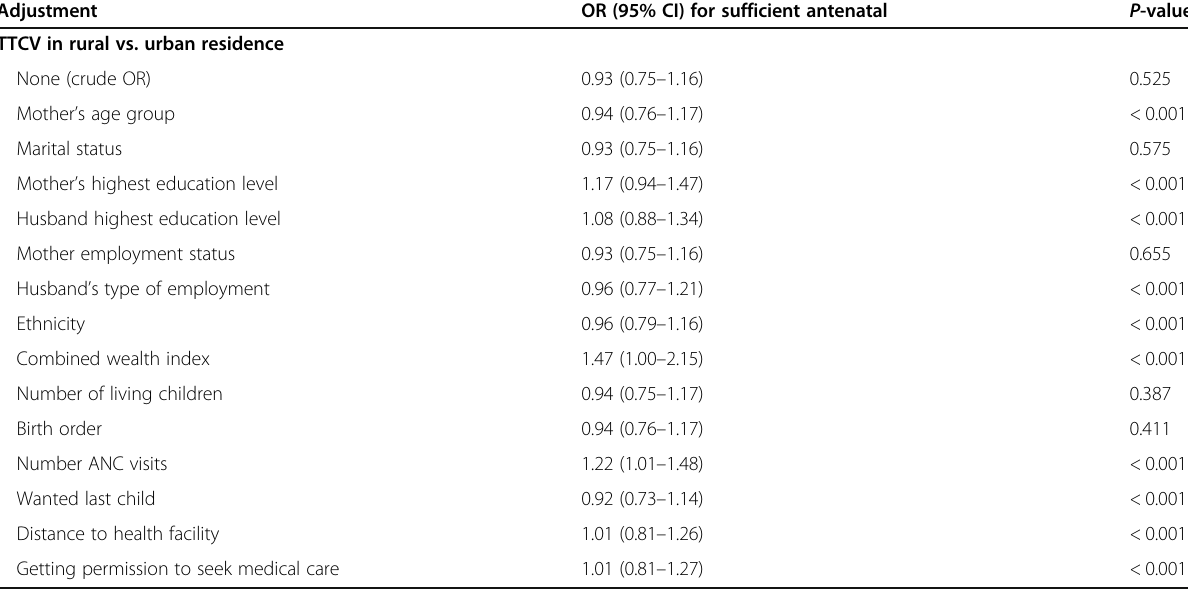
Table 3 Odds ratio of sufficient antenatal tetanus coverage in rural vs. urban area of residence with adjustment for